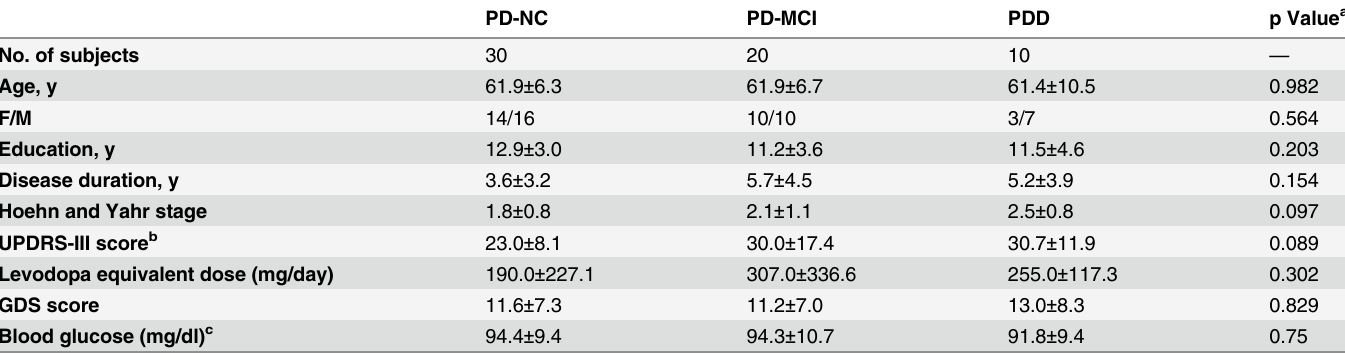
Table 1. Demographic and clinical profiles of